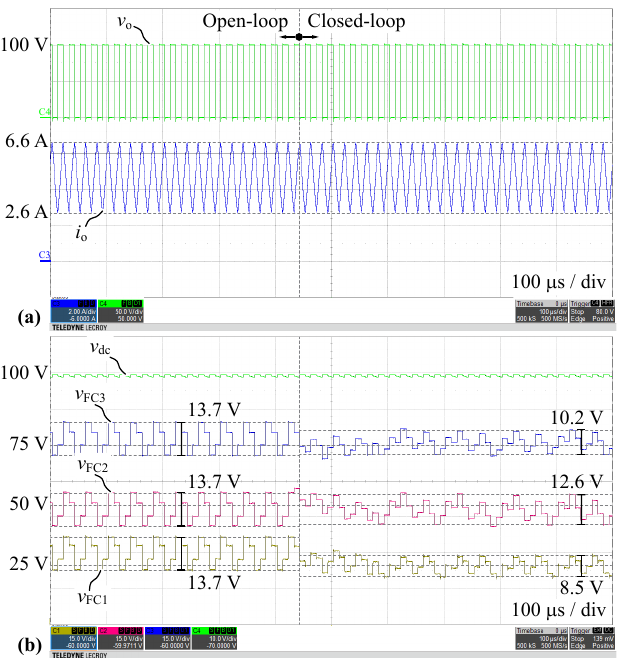
Figure 18. Measured waveforms for Q2L-5L-FCC in configuration 2 (cid:13) with transition from OL ( T delay = 100ns) to CL ( T delay = { 50,100 } ns) balancing with nominal output current ( I o = 4.6A): ( a ) Output voltage v o and current i o , ( b ) DC-link capacitor voltage v dc and FC voltages v FC{1,2,3} .